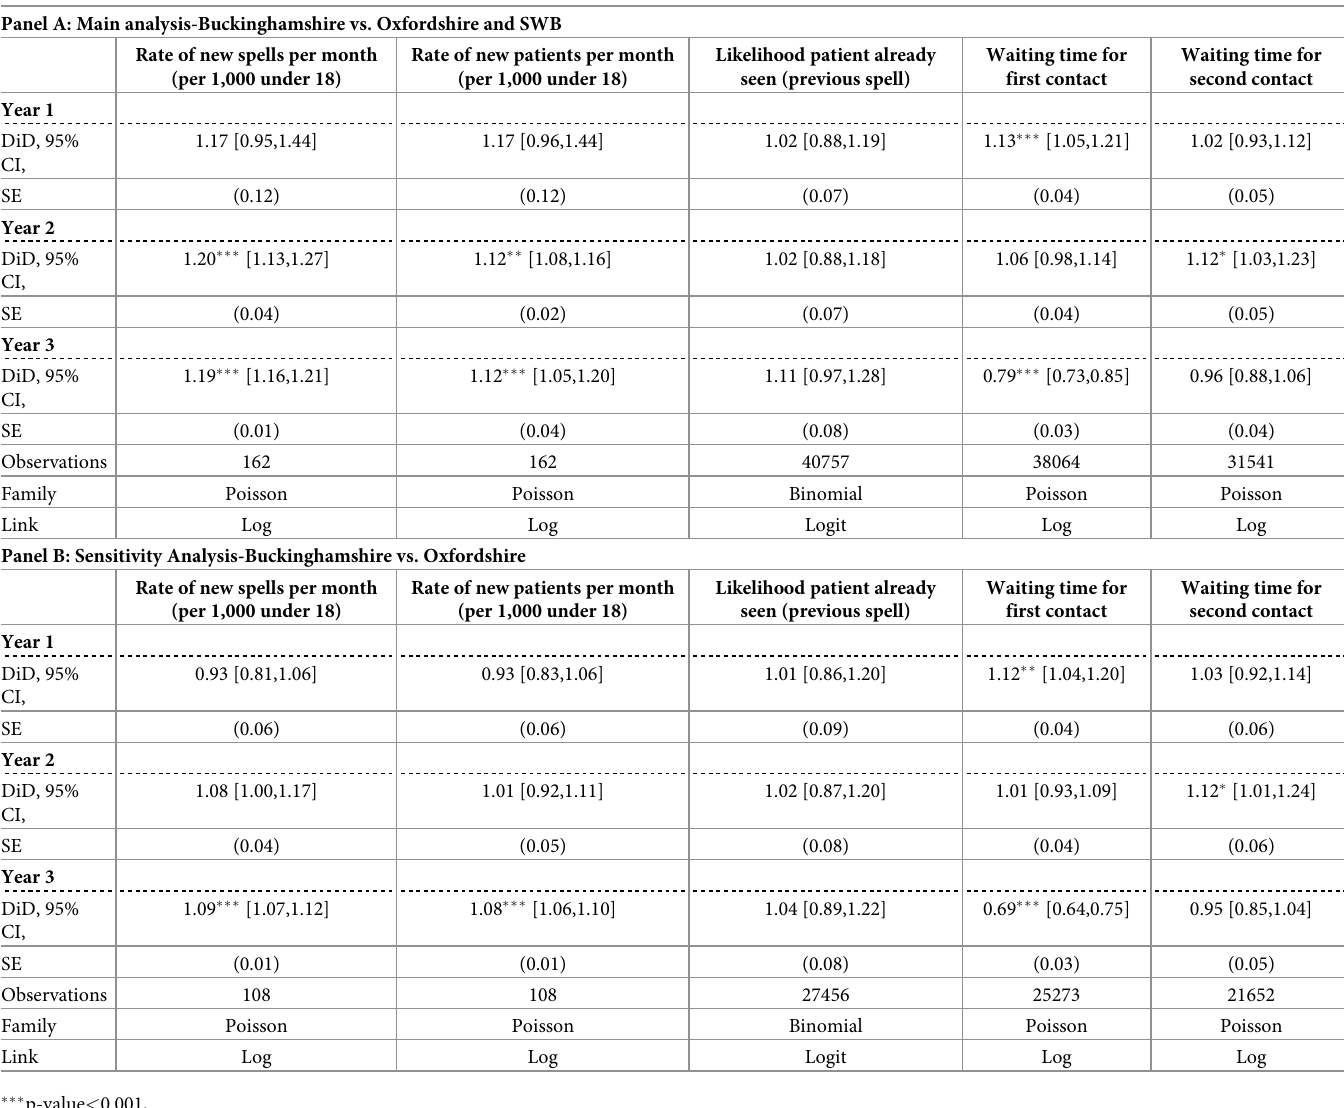
Table 1. Impact of CAMHS transformation in Bucks-main & sensitivity analysis. Panel A: Main analysis-Buckinghamshire vs. Oxfordshire and SWB